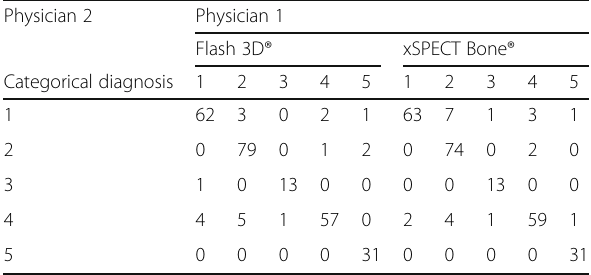
Table 3 Clinical and paraclinical follow-up Plain radiograph 104